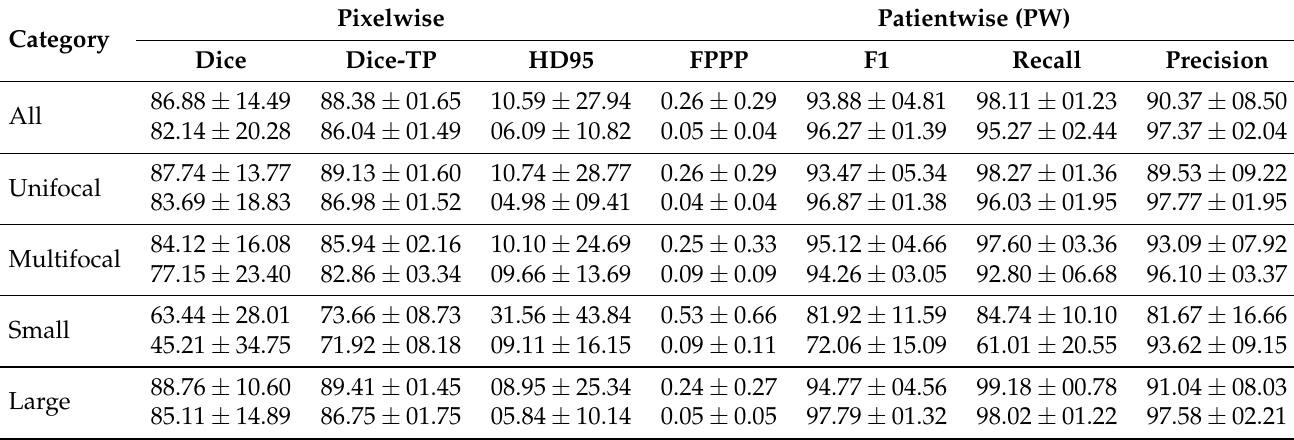
Table 2. Segmentation performances obtained with the two considered architectures using the P1 preprocessing scheme, averaged over the 13 folds of the GS1 subset. For each category, the upper row corresponds to nnU-Net and the lower row to AGU-Net. The tumor volume threshold for the small and large categories was set to 3mL. Pixelwise Patientwise Category